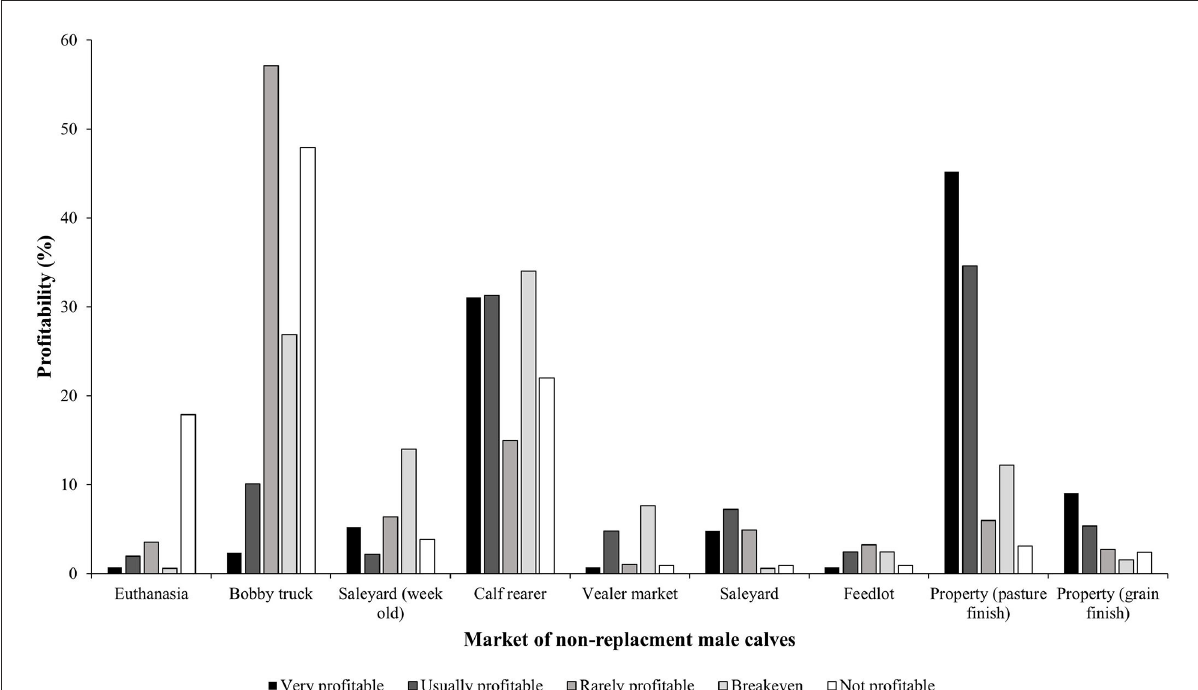
FIGURE5 Profitability of the market accessed for non-replacement male calves reported by Australian dairy producers in 2021 (probabilities reported from the Bayesian model). The color gradient is represented by the following profitability categories from darkest to lightest; very profitable, usually profitable, rarely profitable, breakeven, and not